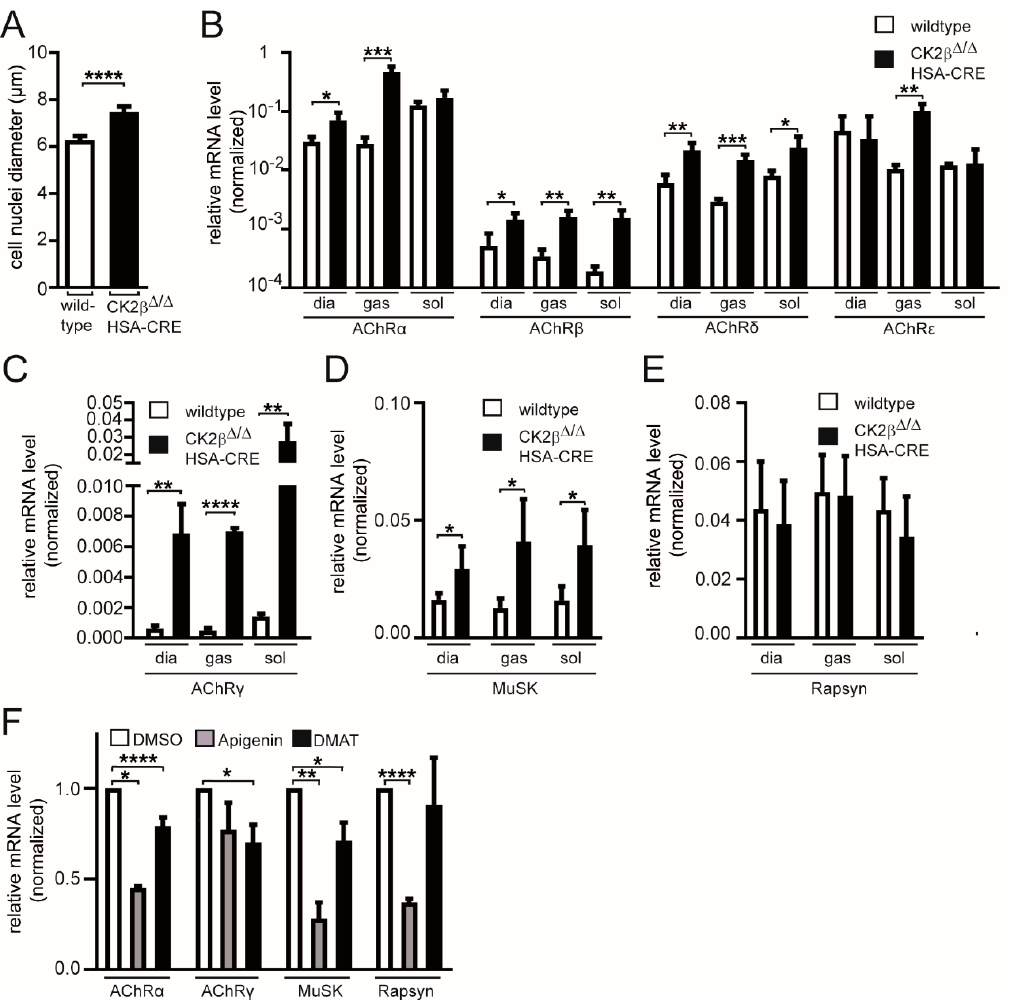
Figure 6. Gene expression levels for postsynaptic genes in the absence of CK2 β . ( A ) Analysis of cell nuclei diameter in soleus muscle of wild-type and conditional CK2 β -deficient mice. Analyzed cell nuclei were significantly bigger in diameter in CK2 β -deficient muscles when compared to wild-type cell nuclei (**** p < 0.0001; unpaired two-tailed Student’s t-test; soleus wild-type; n > 50 cell nuclei, CK2 β -deficient soleus n > 50 cell nuclei). Cell nuclei were sampled from three mice per genotype. ( B – E ) Relative transcript levels for AChR α , AChR β , AChR δ , AChR ε ( B ), AChR γ ( C ), MuSK ( D ), and Rapsyn ( E ) in diaphragm, gastrocnemius, and soleus muscle, as determined by quantitative PCR. Relative transcript levels of AChR β , AChR δ ( B ), AChR γ ( C ), and MuSK ( D ) were significantly elevated in diaphragm, soleus, and extensor digitorum longus (EDL) (*** p < 0.001, ** p < 0.01; * p < 0.05; unpaired two-tailed Student’s t-test; n > 3 muscles per genotype). ( F ) After incubation of C2C12 muscle cells with common CK2 inhibitors Apigenin and DMAT, the transcript levels of typical postsynaptic genes were significantly reduced (**** p < 0.0001, *** p < 0.001, ** p < 0.01; * p < 0.05; unpaired two-tailed Student’s t-test; n = 3 cell sets).